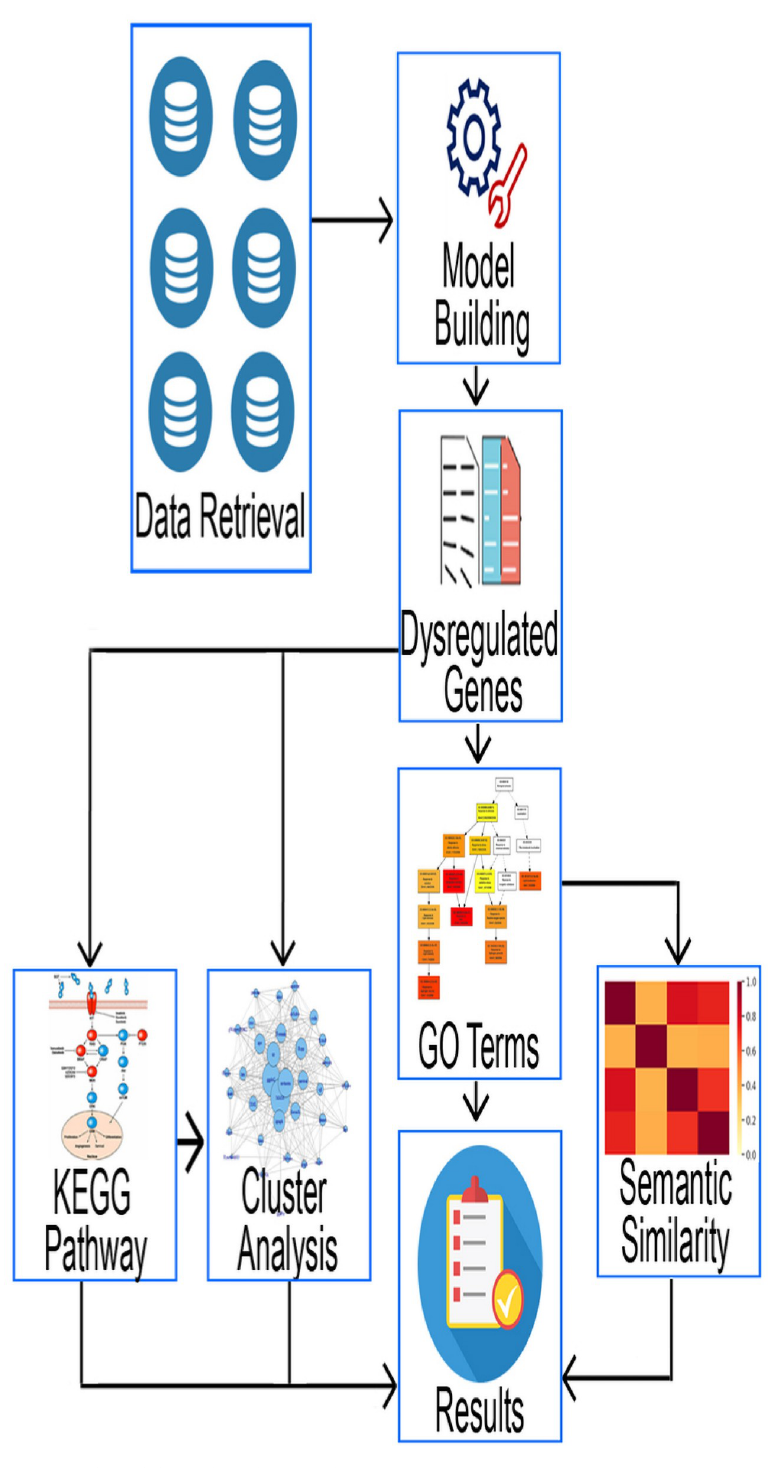
Fig 1. Pipeline of the analytical